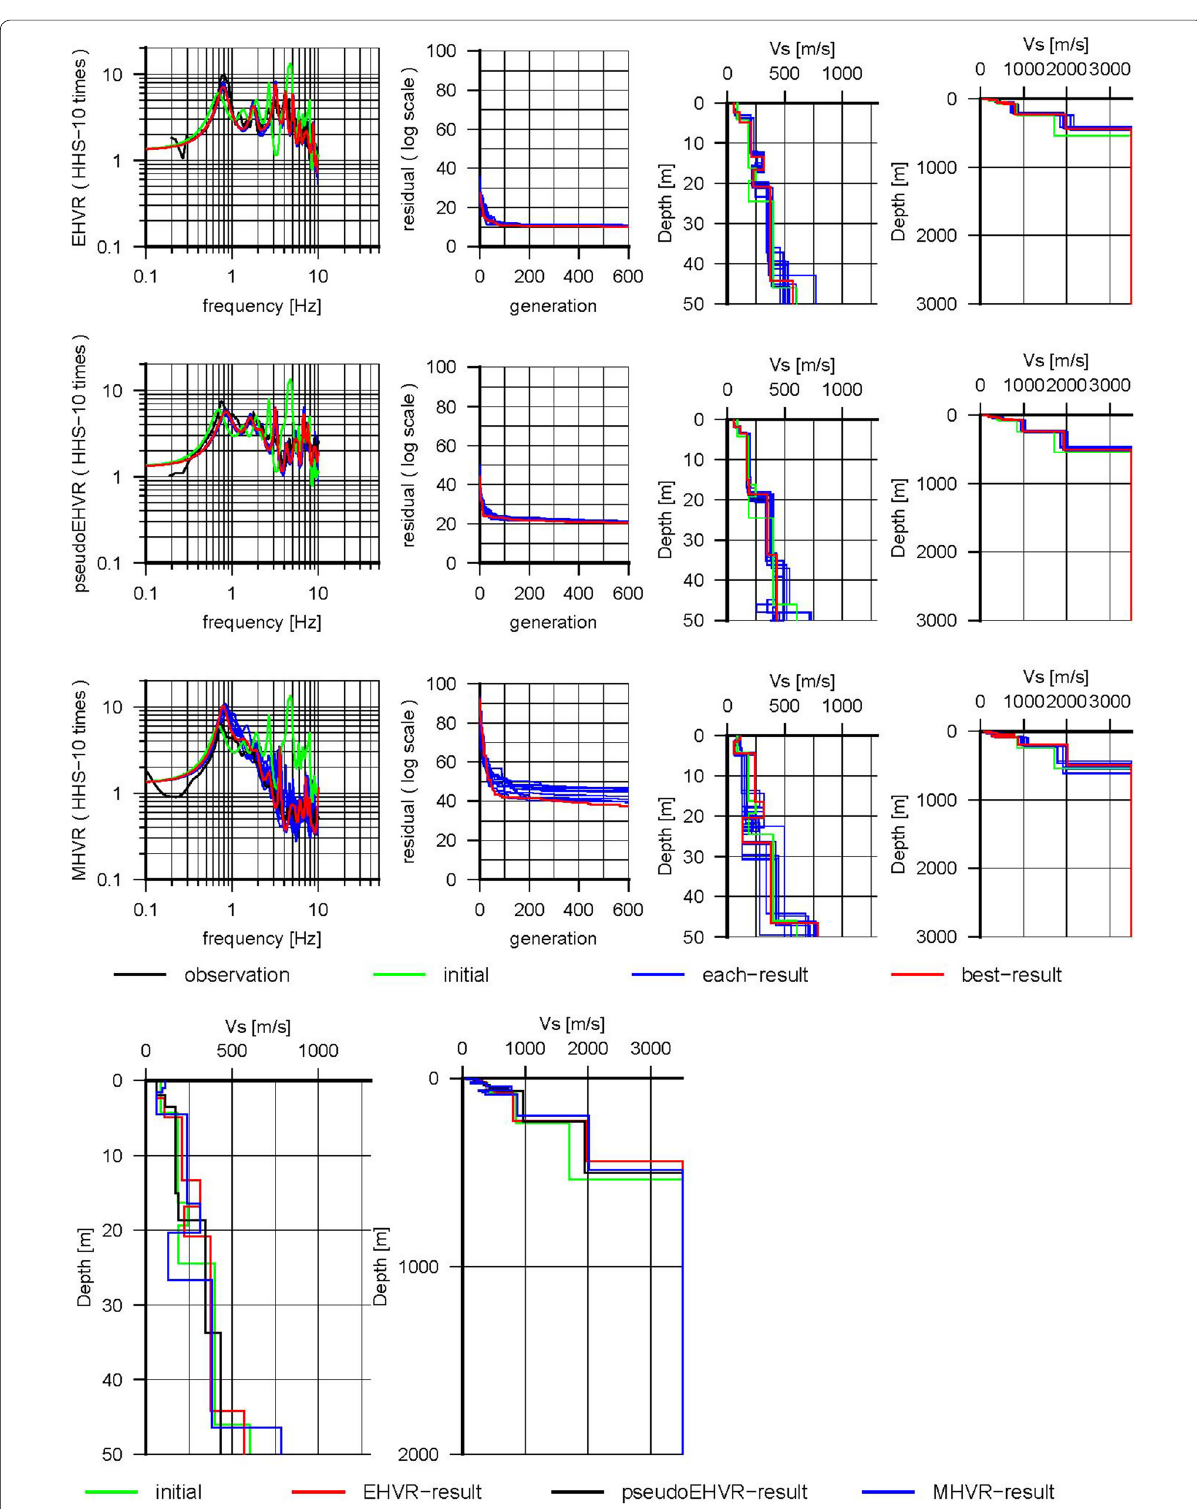
Fig. 21 Inversion results at TRMA when a priori underground structure model of Satoh et al. (2001a) is used as the initial